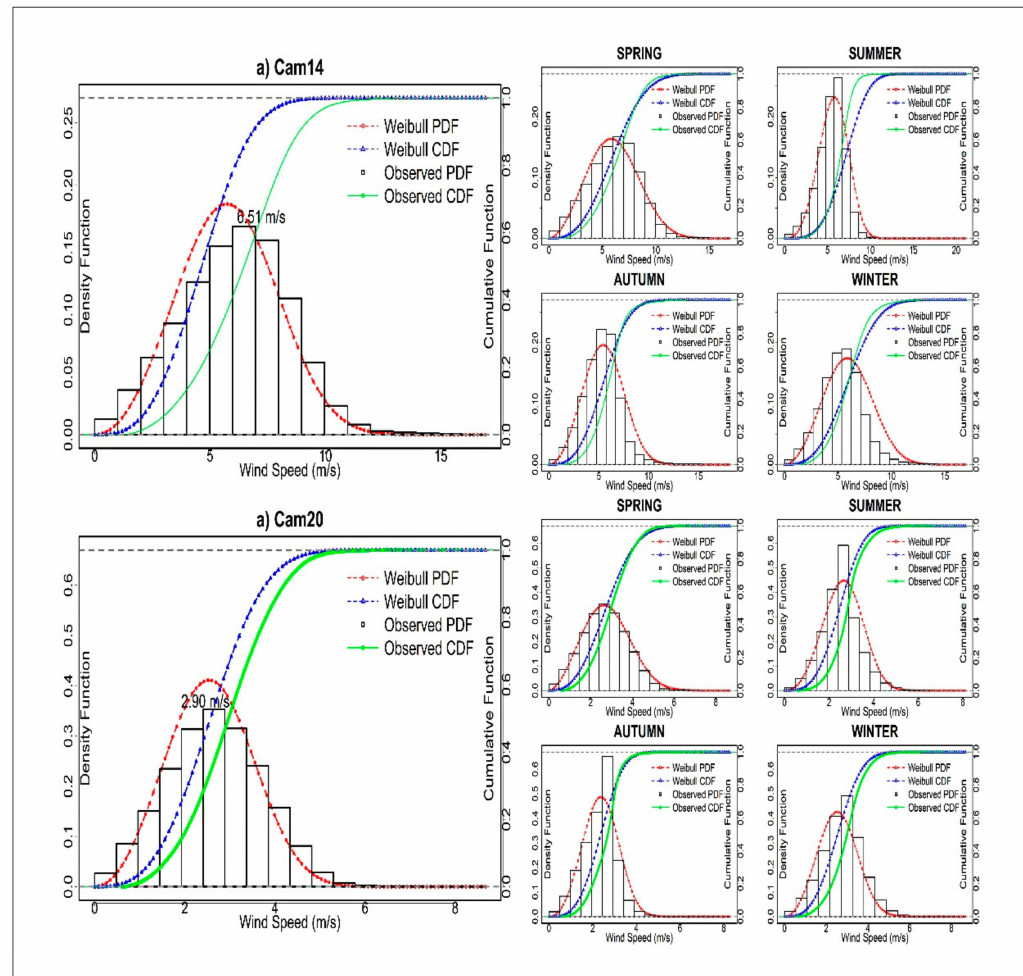
Figure 7. Annual and seasonal Weibull distributions for the state of